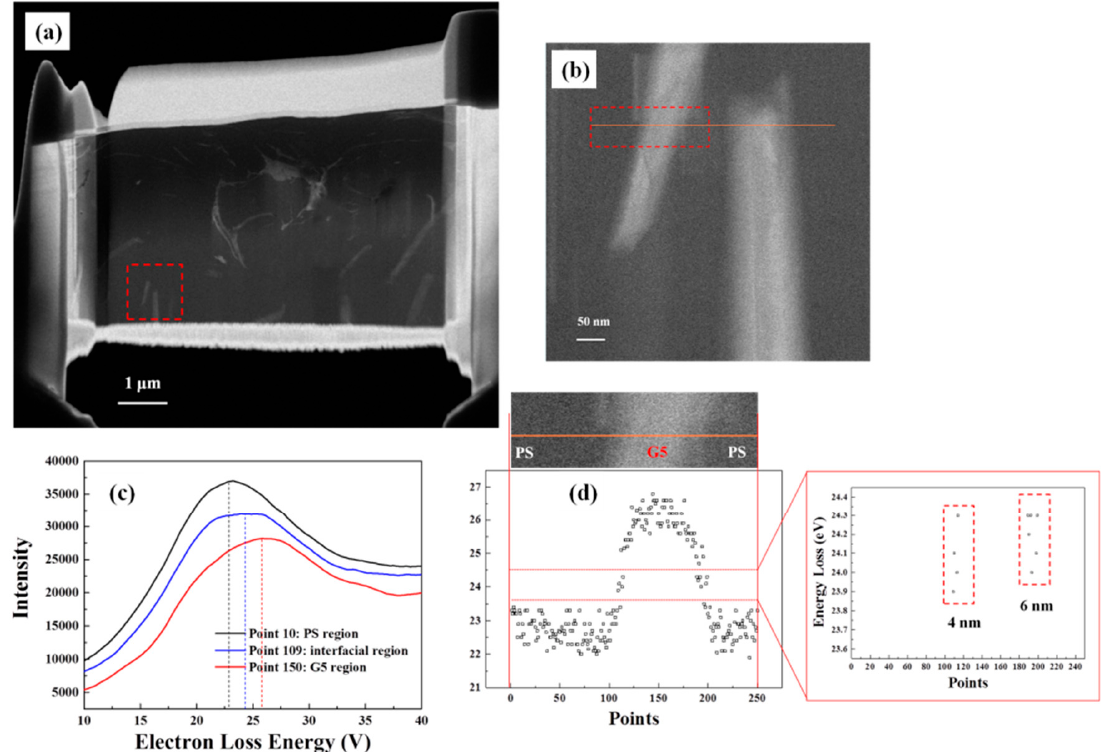
Figure 4. ( a ) The fracture image by scanning transmission electron microscopy (STEM) for PS/G5-9%; ( b ) Higher magnification for the red area in ( a ); ( c ) The energy loss spectra of C-K edges for three points which stand for three regions in the orange line of ( b ); ( d ) Peak positions extracted from electron energy-loss spectroscopy (EELS) acquired from image ( b ), shown as a function of the acquisition order from point 1 to point 250.